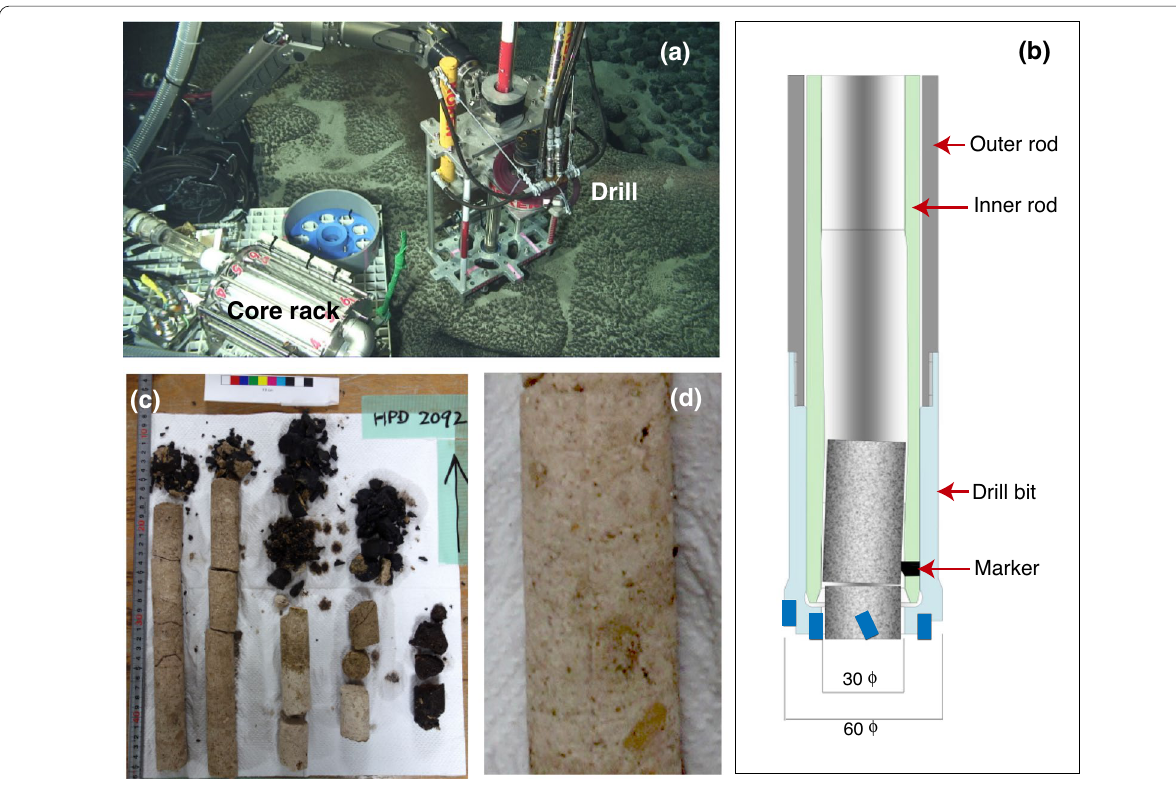
Fig. 2 Coring apparatus and drilled cores. a The coring apparatus drilling the seafloor covered with manganese crust and a core rack installed on the ROV Hyper-dolphin, b cross section of the drilling rod, c photo of the cores collected during the Dive 2092 of the ROV Hyper-dolphin, and d orientation line along a core marked during drilling